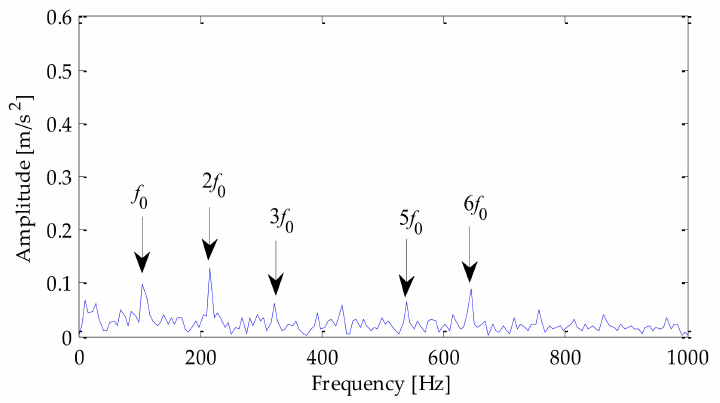
Figure 42. Analysis of signal envelope spectrum after noise reduction based on LMD–RobustICA.